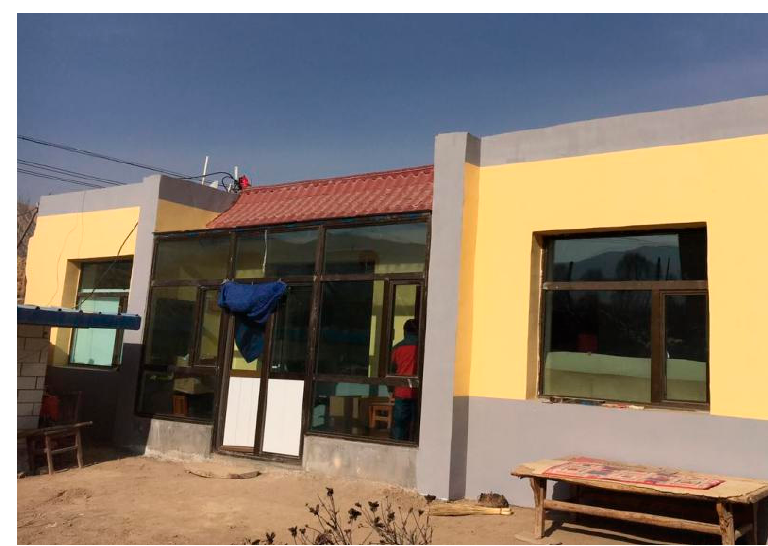
Figure 1. Picture of the residential building appearance.